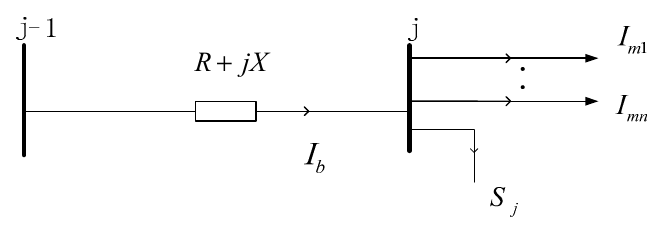
Figure 2. Structure of AC series components.